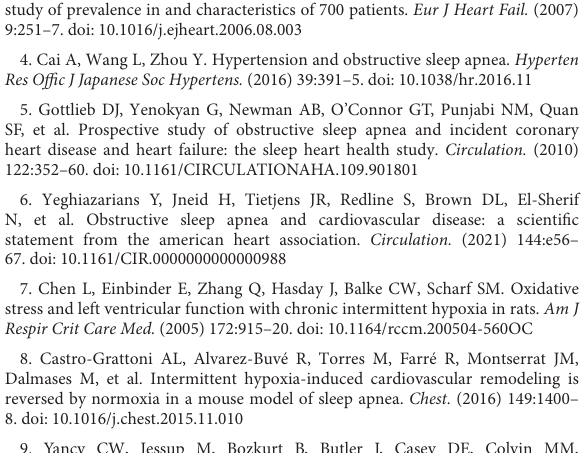
causes. Surgical failed: TAC surgical ligation was wrongly positioned or the operation time was too long, the mice suffered from respiratory